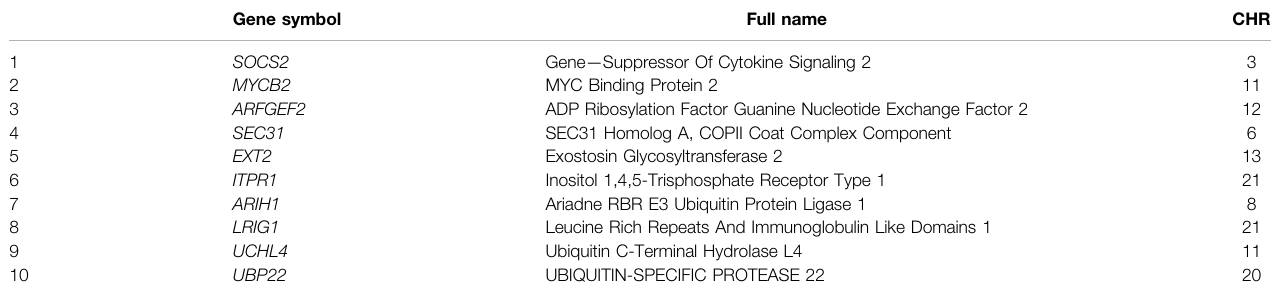
TABLE 3 | The top ten genes from Persian sheep Gene symbol